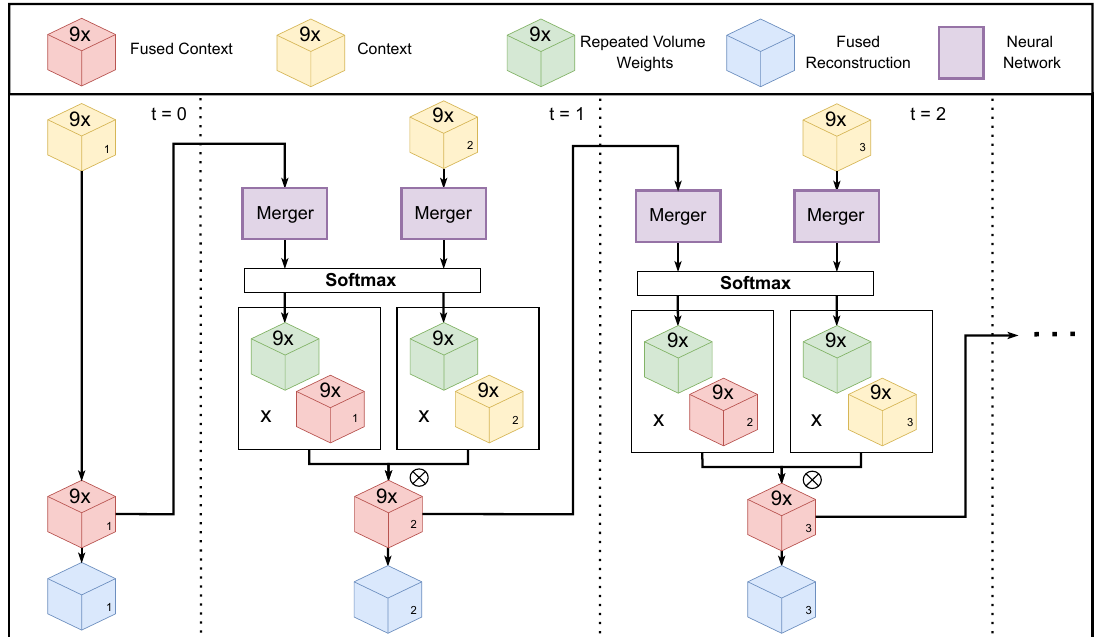
Figure 3. Adaptation for iterative 3D reconstruction presented in this work. We gradually refine a fused reconstruction maintained in memory. When a new input image becomes available, a new context tensor is produced by an encoder–decoder block, as shown in Figure 2. The updated fused context tensor is obtained as a weighted sum of the new context tensor and the previous fused context tensor. Whereas Pix2Vox only merges coarse reconstructions, we merge complete context tensors. To account for the additional channels during the merging, the score maps are repeated 9